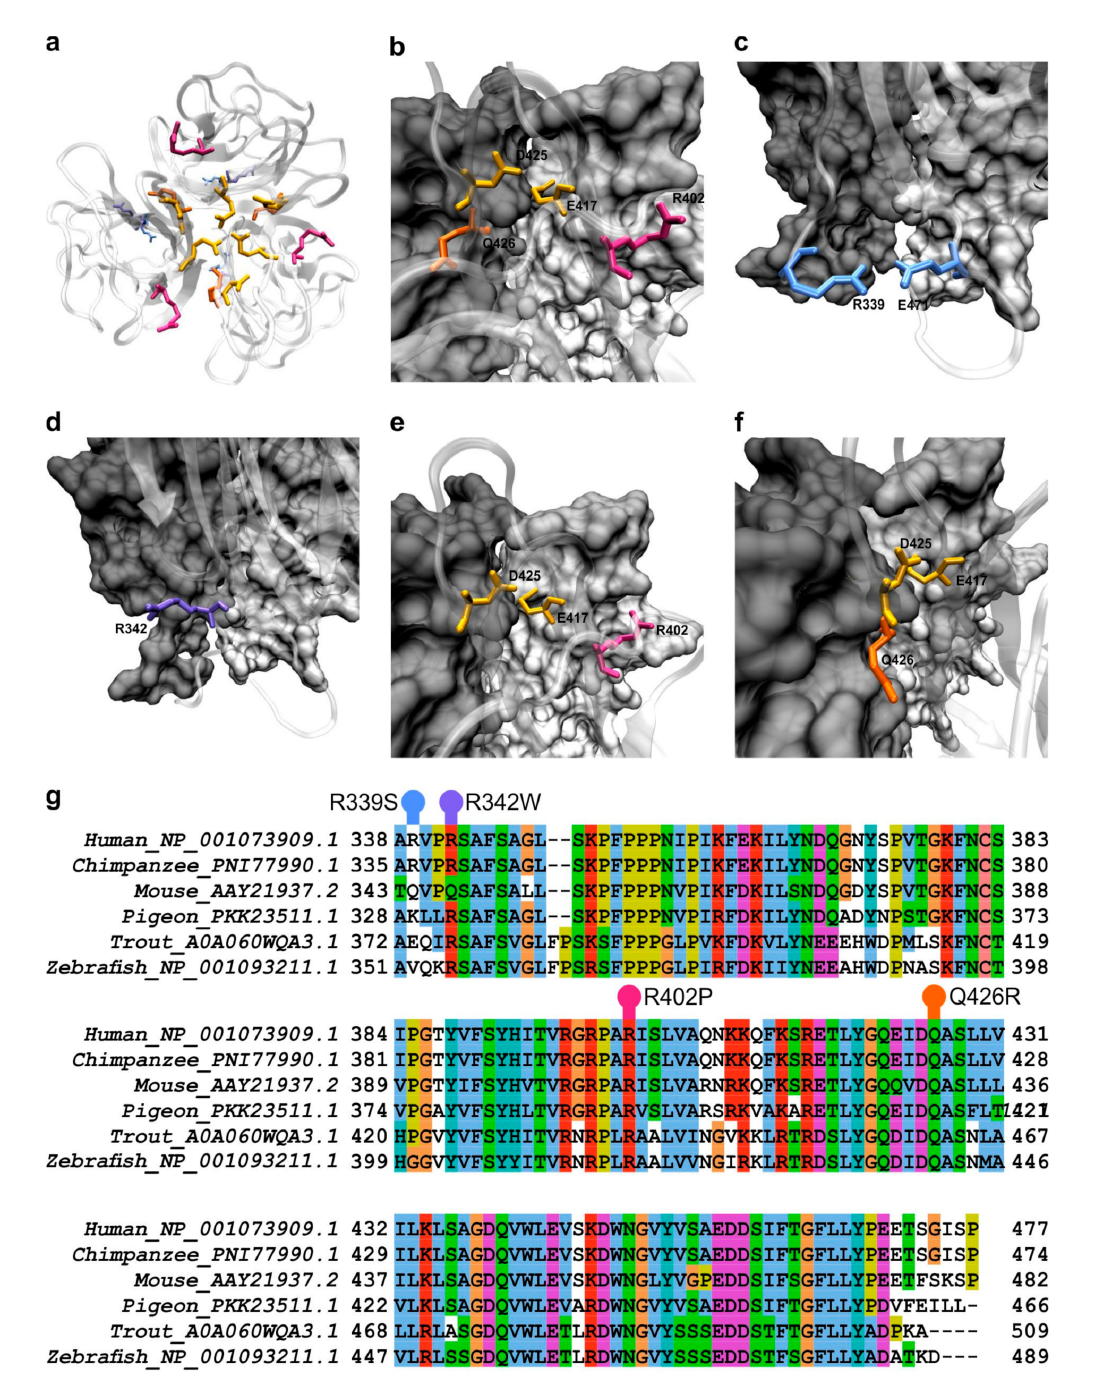
Figure 1. Structural and evolutionary context of the analyzed variants of hOtolC1q. ( a – f ) SAXS model of trimeric hOtolC1q with residues shown as sticks: R339S in light blue, R342 in deep blue, R402P in magenta and Q426R in orange. The E417 and D425 residues forming a Ca 2+ binding site are shown in yellow. In a , all protomers are shown in a “cartoon” representation, in ( b – f ), one protomer is shown as translucent protein backbone, two others as light and dark gray protein surface projections. ( a )—overall view of the gC1q trimer, ( b )—Ca 2+ binding site at the top of the trimer, ( c )—R339, near the base of the trimer, with adjacent E471, ( d )—R342 near the contact surface of the protomers, ( e )—R402, and ( f )—Q426, both near the Ca 2+ binding site and the contact surface of the protomers. The visualizations were made using VMD [28]. ( g )—Multiple sequence alignment showing the conservation of the gC1q domain of otolin-1 among the classes of the vertebrates. Investigated residues are highlighted above the alignment. The alignment was done using ClustalX [29] and visualized using Jalview